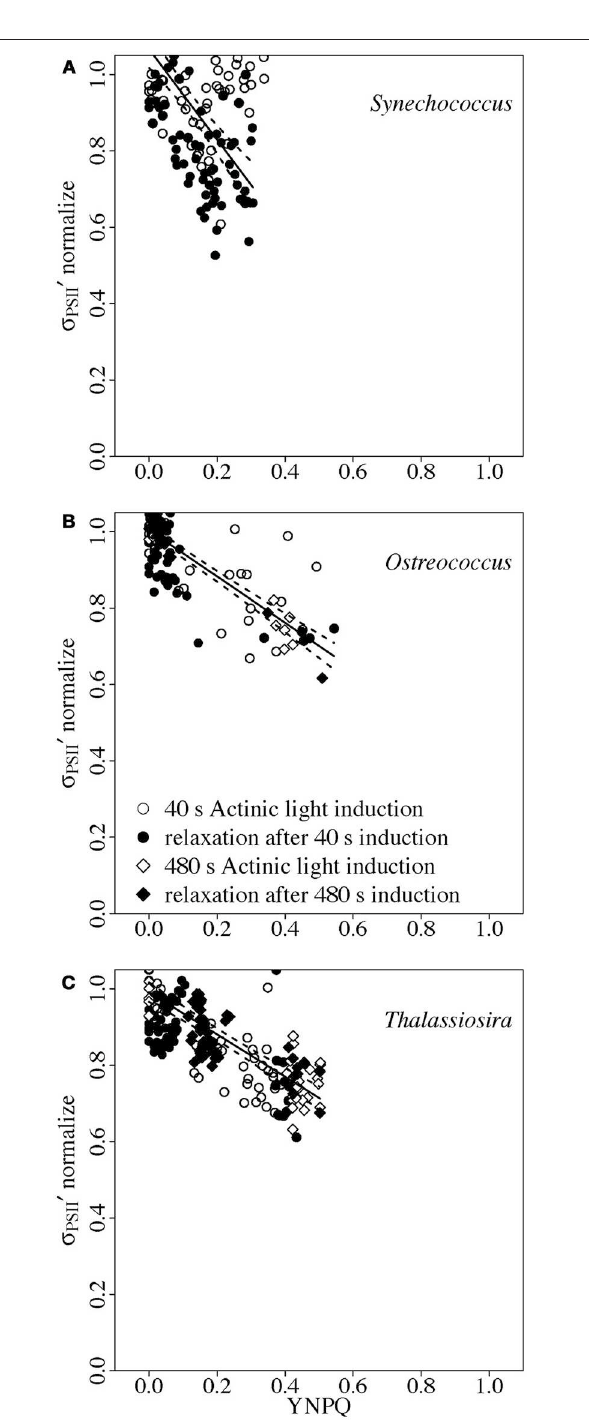
FIGURE 7 | Normalized σ PSII ′ vs. YNPQ in Synechococcus (A) , Ostreococcus (B) , or Thalassiosira (C) from growth saturating light. Induction of YNPQ was driven by a time course exposure to saturating light (open symbols) for 40s (circles) or 480s (diamonds) ( Figure 1B ). Subsequent relaxation of YNPQ was thereafter tracked in darkness ( Figure 1B ) (closed symbols). σ PSII ′ was normalized to the regression intercept for a particular data set to scale change in σ PSII ′ from 1 to 0. Paired determinations from 4 to 8 replicate cultures plotted individually. Solid lines show linear regressions; dotted lines show 95% C.I. on the regression